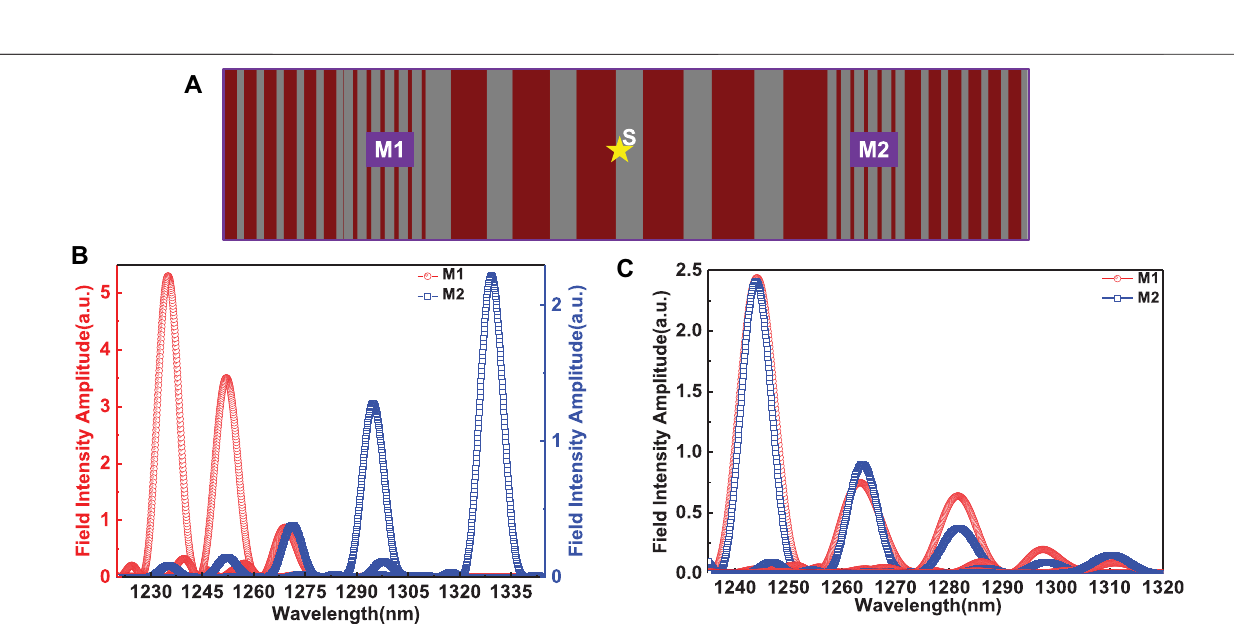
FIGURE 4 | (A) FDTD set up of grid size 30/ a 1 with placing a Gaussian source in the middle of the trapped PC and two monitors (M1, M2) to the left and right, respectively; The electric fi eld intensity amplitude ( E 2 z ) of (B) unidirectional (C) bidirectional rainbow